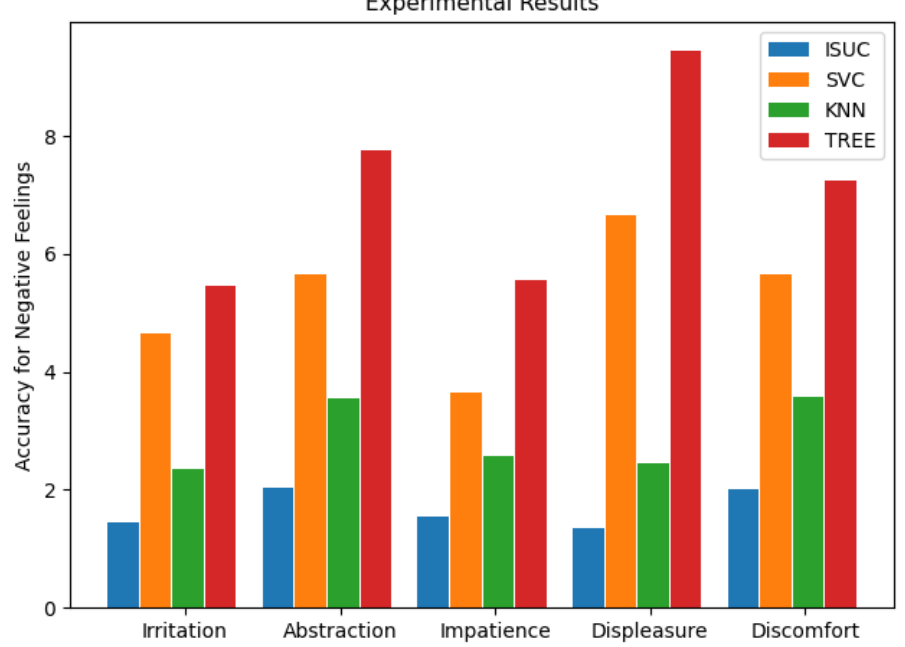
Figure 5. Shows the experimental outcomes for negative